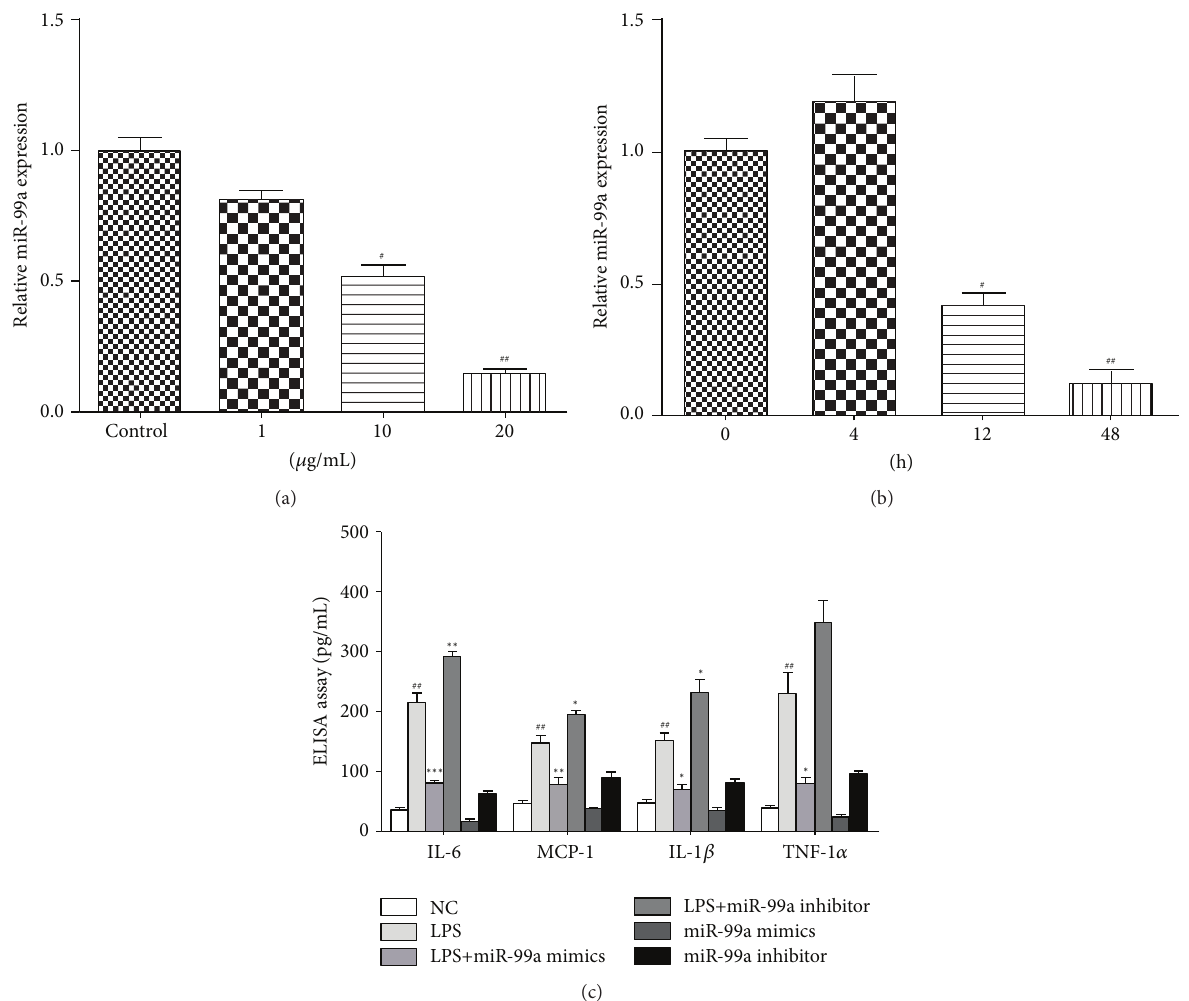
Figure 1: Effects of LPS on miR-99a production and effects of miR-99a on LPS-induced inflammation in HUVECs. (a) Effects of LPS treatment at different concentrations for 24 hours on miR-99a expression; (b) effects of different time treatment with LPS (20 𝜇 g/mL) on miR-99a expression; (c) effects of miR-99a on LPS-induced inflammatory factors secretion. The values (mean ± SD from three independent experiments). # 𝑃 < 0.05 ; ## 𝑃 < 0.01 versus control; ∗ 𝑃 < 0.05 ; ∗∗ 𝑃 < 0.01 versus LPS group; ∗∗∗ 𝑃 < 0.001 versus LPS